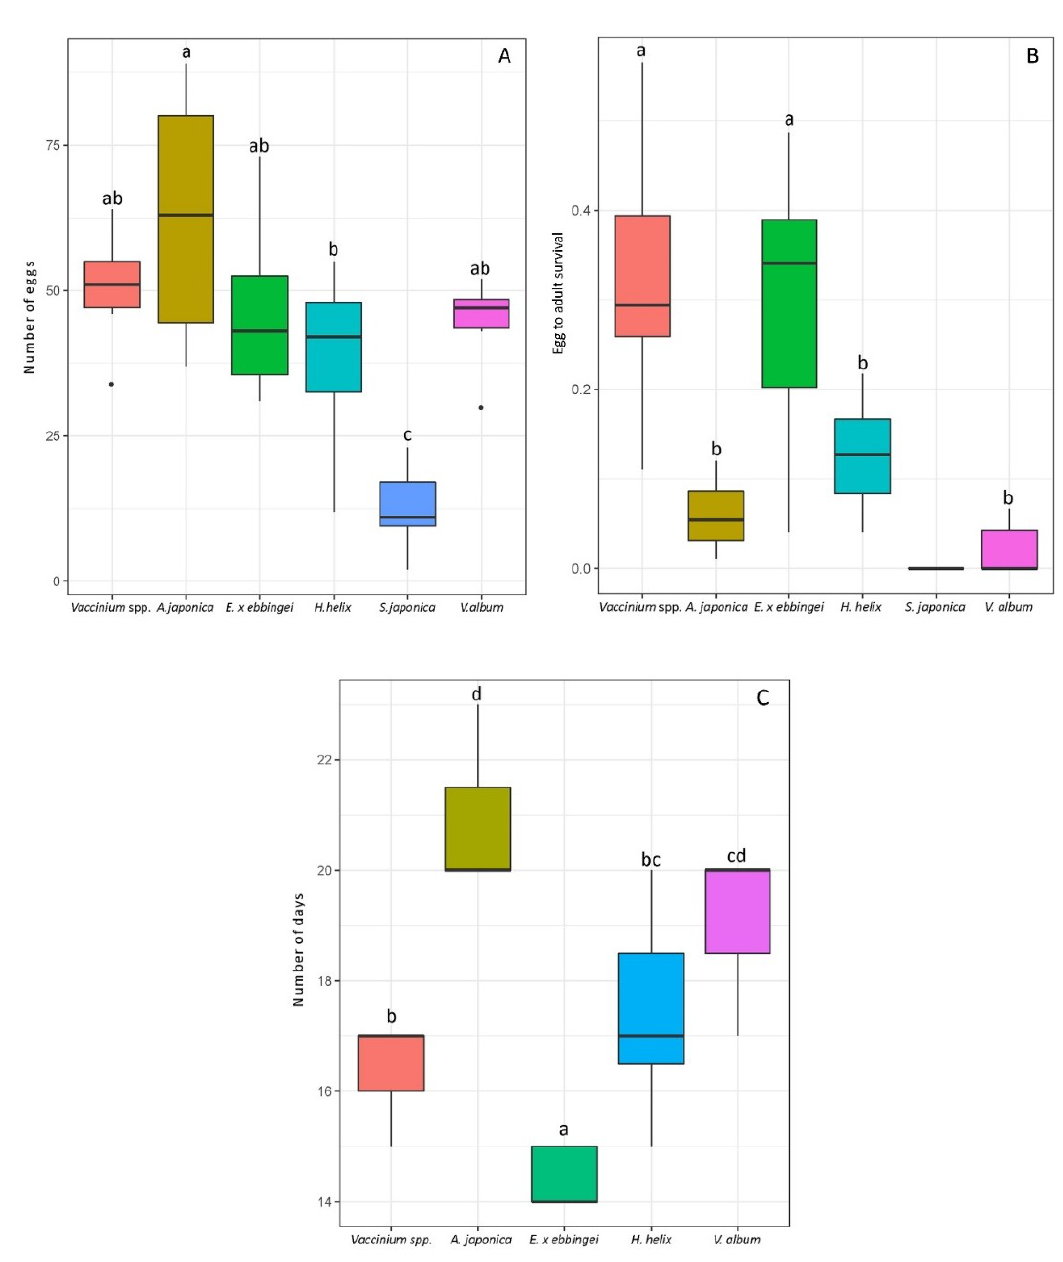
Figure 4. Performance of D. suzukii on various early spring hosts and on blueberries in no-choice laboratory experiments. Blueberries ( Vaccinium spp.) are included to serve as a reference point for the pest performance on a preferred and suitable commercial crop. Boxplots provide the data for seven biological replicates per fruit species, each containing six to 14 berries depending on host species size: ( A ) Number of eggs laid on intact field-collected early spring host fruits; ( B ) Egg-to-adult survival; ( C ) Developmental time of D. suzukii adults emerged from the same fruits. Letters indicate statistical differences ( p < 0.05) after Tukey’s multiple comparison test.